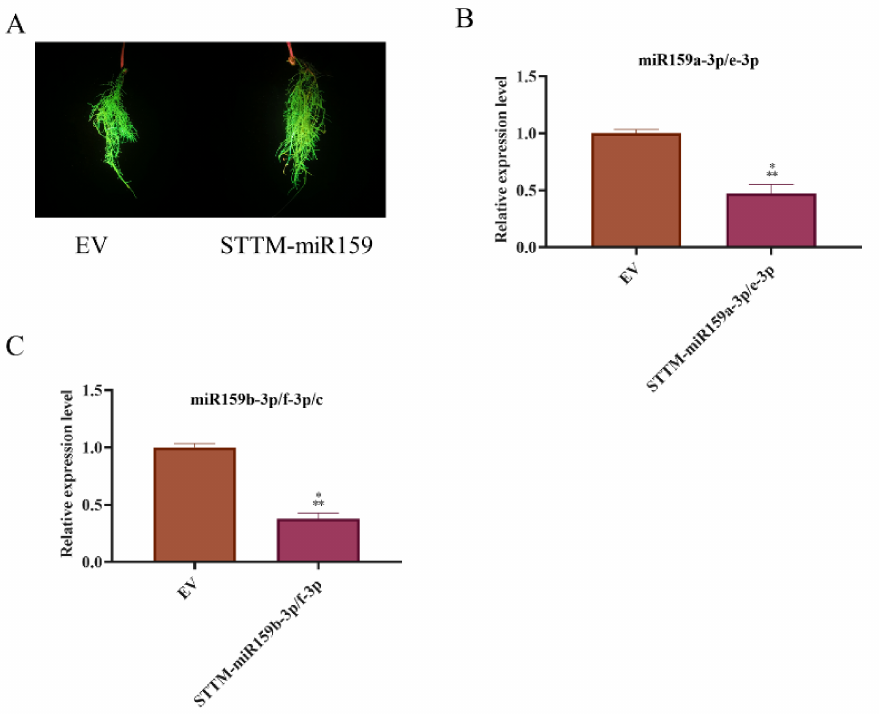
Figure 5. The expression level of miR159 in transgenic STTM-miR159 soybean hairy roots. ( A ) Soybean hairy roots with strong GFP signal, EV, hairy roots of empty vector, STTM-miR159, soybean hairy roots of short tandem target mimic (STTM) of miR159. ( B , C ) The relative expression level of mature sequences of miR159 detected by qRT–PCR. Expression levels of miR159 in STTM were relative to EV with soybean U6 gene as the internal reference gene. t -test was applied to compare differences between STTM and EV hairy roots. ***, significant difference found at p < 0.001 level. Error bars represent standard deviation from the